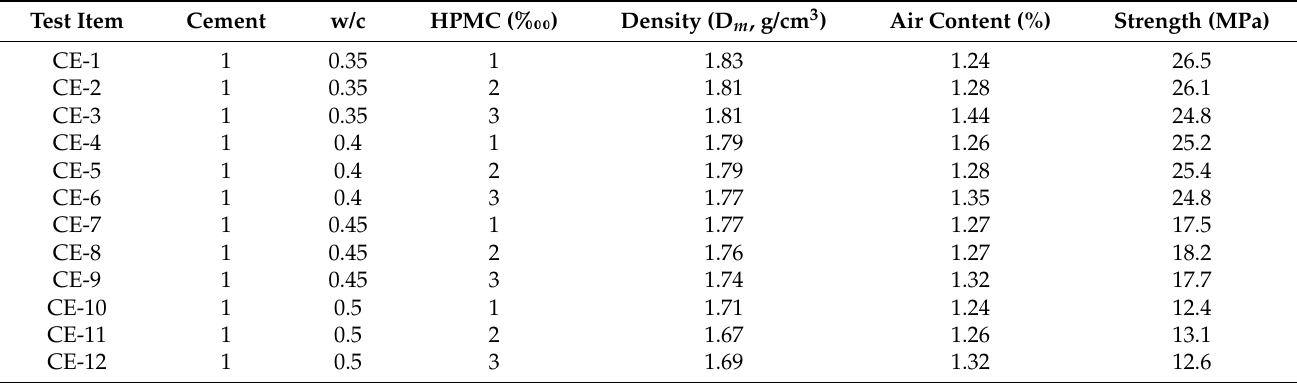
Table 2. Mixing proportions of the cement mortars and test